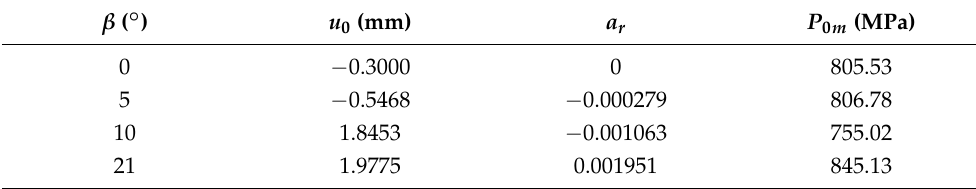
Table 10. Optimization results for different helical angles β